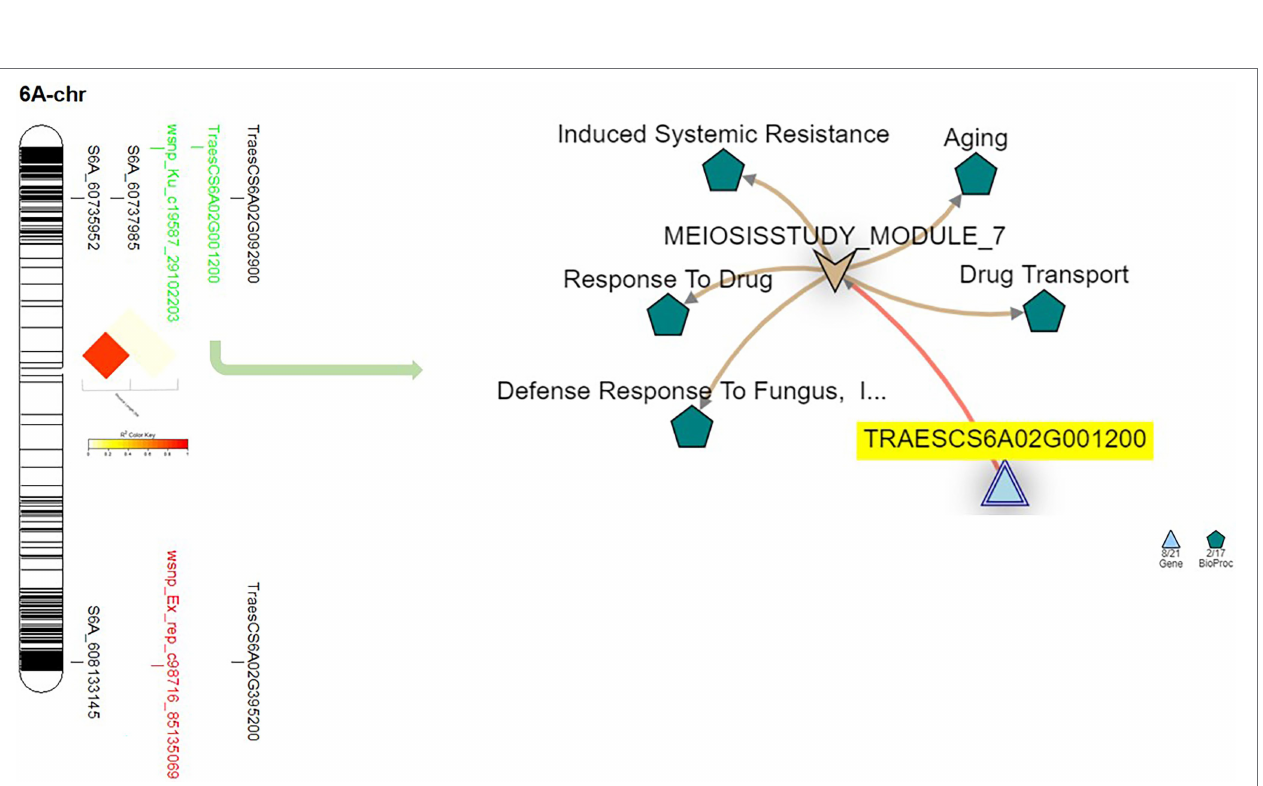
FIGURE 4 | The linkage disequilibrium between each pair of the significant marker identified on 1B chromosome, the gene model they are harboring, and the gene network of the identified gene models in related to disease resistance.